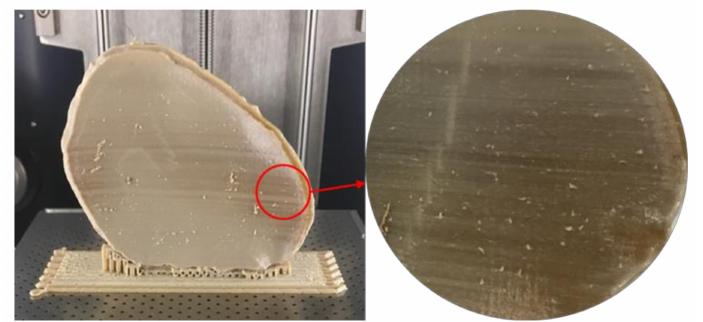
Figure 9. Signs of slight discoloration (dark-brownish areas) in Group 1